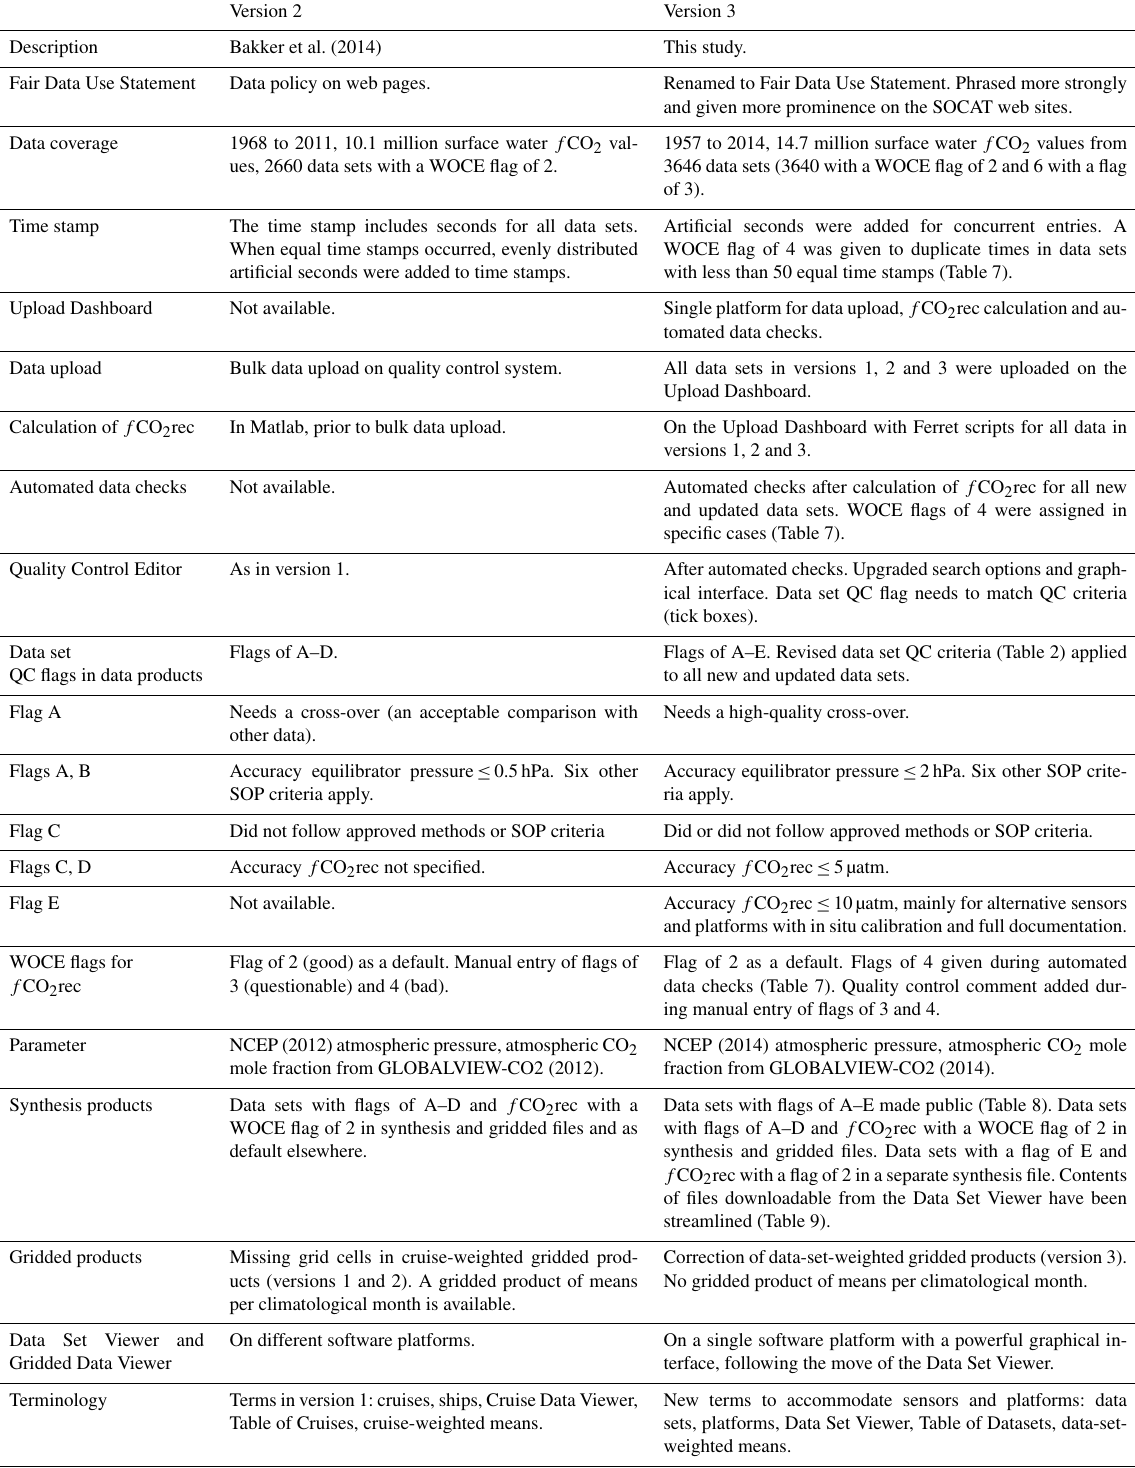
Table 1. Key differences between SOCAT versions 2 and 3. See text and Table 2 for further detail and an explanation of cross-overs and standard operating procedures (SOPs). Calculation of “recommended f CO 2 ” ( f CO 2 rec) is explained in Sect.